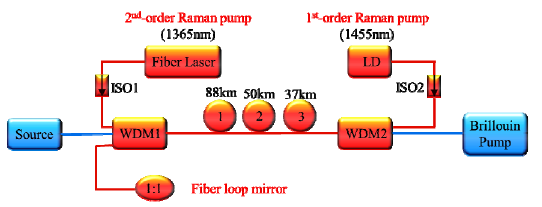
Fig. 6 Principle diagram of the HDA method.